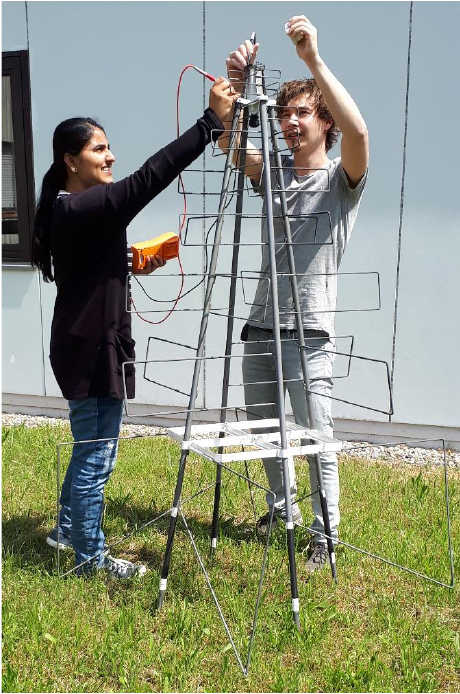
Figure 5. Photo of a SKALA antenna installed at KIT for testing